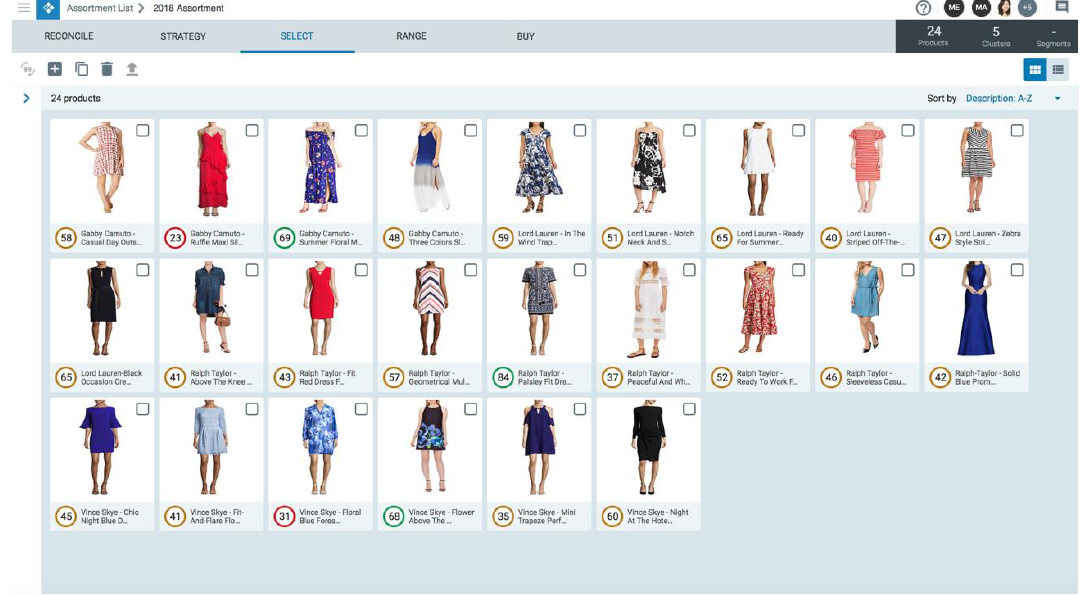
Figure 2. Twenty-four products displayed per task.